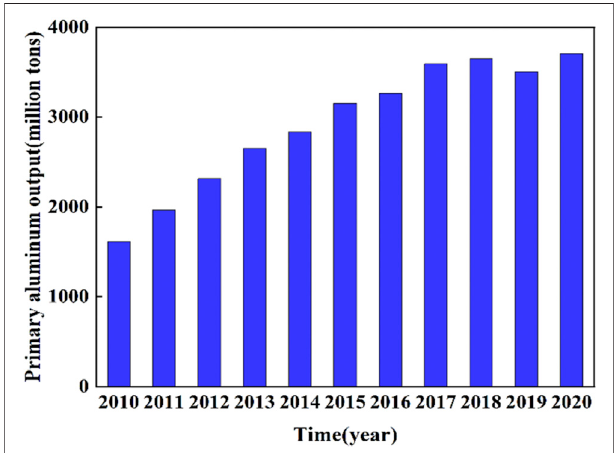
FIGURE 1 | China ’ s primary aluminum output from 2010 to